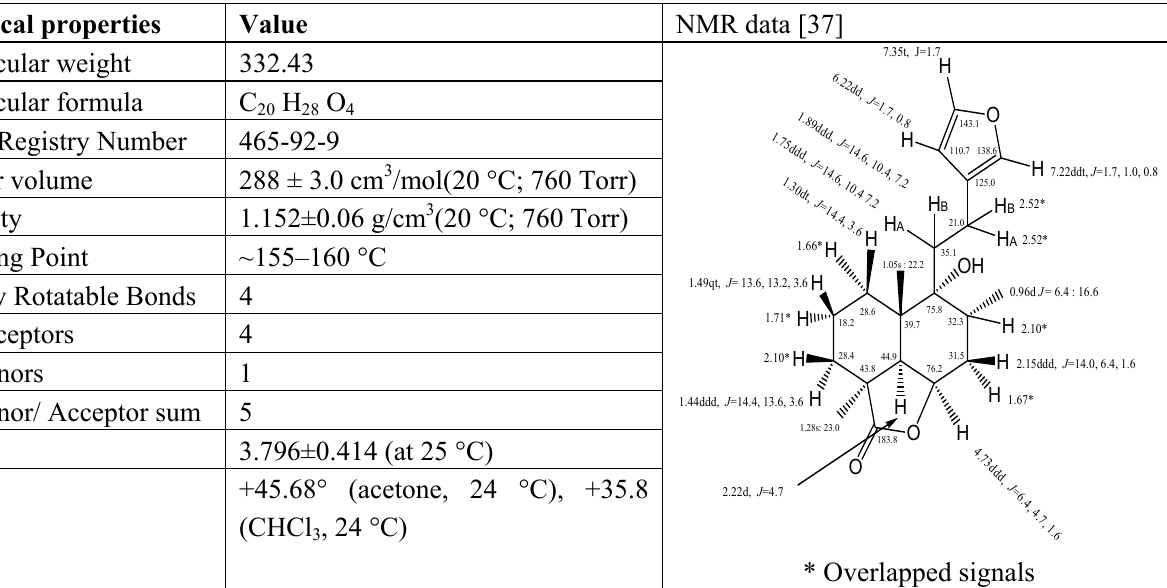
Table 1 . Physical properties and 1 H-NMR data of marrubiin